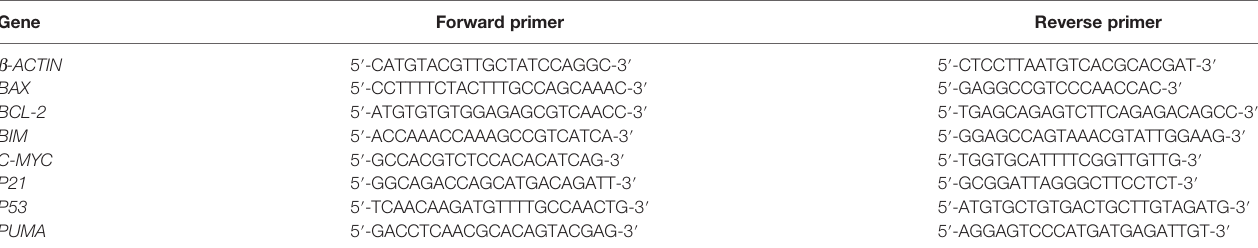
TABLE 1 | Primer sequences used for qPCR